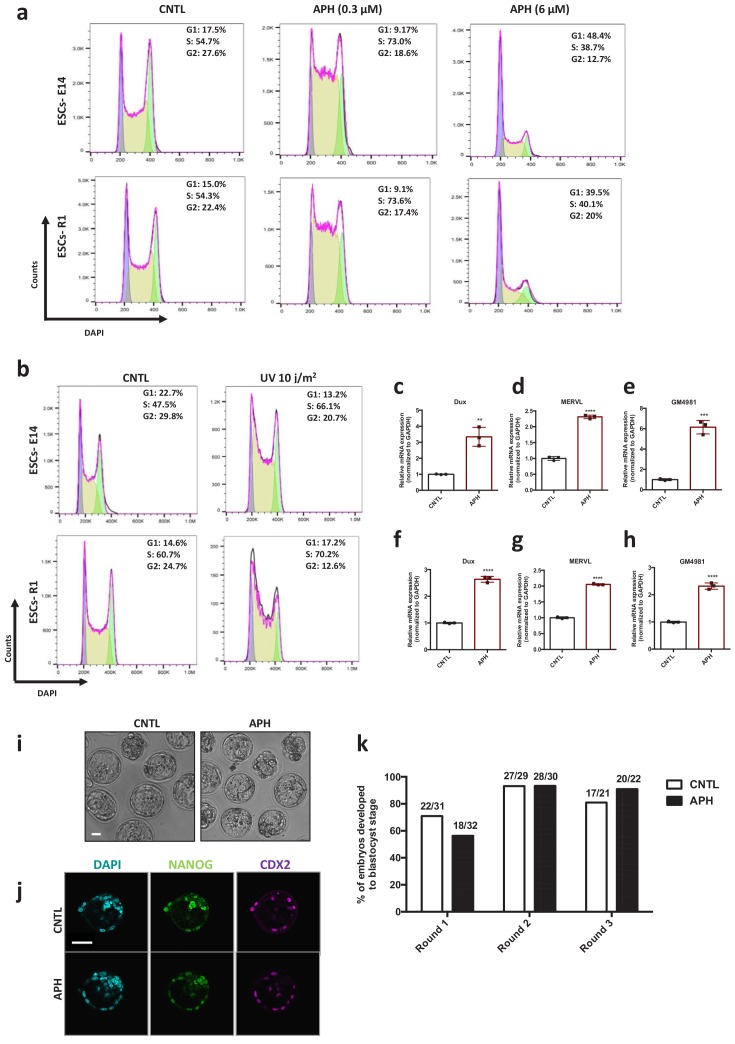
Characterization of APH-induced 2C-like cells.(a) Cell cycle analysis of E14 and R1 ESCs upon treatment with low (0.3 μM) and high (6 μM) concentrations of APH. (b) Cell cycle analysis of E14 and R1 ESCs upon UV treatment. (c-e), (f-h) Two replicates of RT-qPCR analysis on blastocyst-stage embryos for key 2C-specific genes Dux, Gm4981 and MERVL. (i) Wide field microscope images of mouse embryos at blastocyst stage after APH treatment (bar = 25 µm) (j) Immunostaining of blastocyst-stage embryos for key ESCs marker, NANOG and the key TSC marker, CDX2 after APH treatment (bar = 50 µm). (k) Percentage of embryos developed to the blastocyst stage after APH treatment in three replicates. Statistical significance compared to CNTL unless otherwise indicated. All bar plots show mean with ± SD (*p≤0.05, **p≤0.01, ***p≤0.001, ****p≤0.0001, one-way ANOVA).